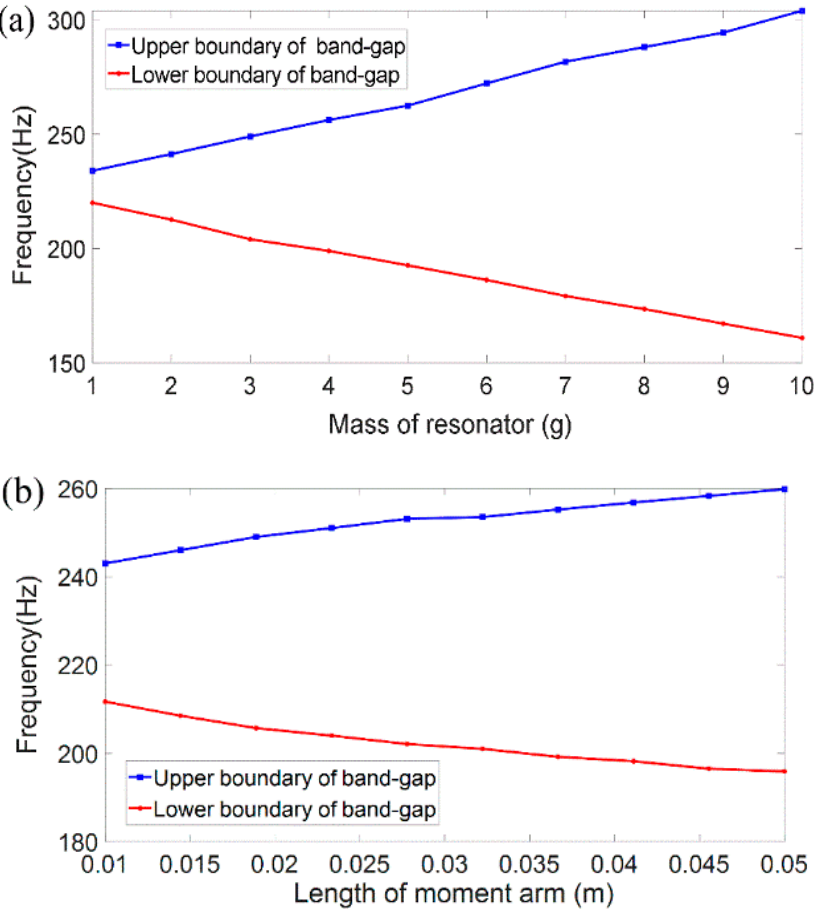
Figure 6. ( a ) The upper and lower boundaries of the band-gaps as a function of ( a ) the mass and ( b ) the moment arm of a resonator with the same natural frequency of the resonator 227 Hz.